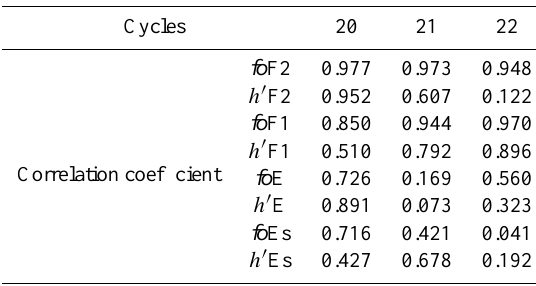
Table 1. Evolution of different correlation coefficients with solar activity. Cycles